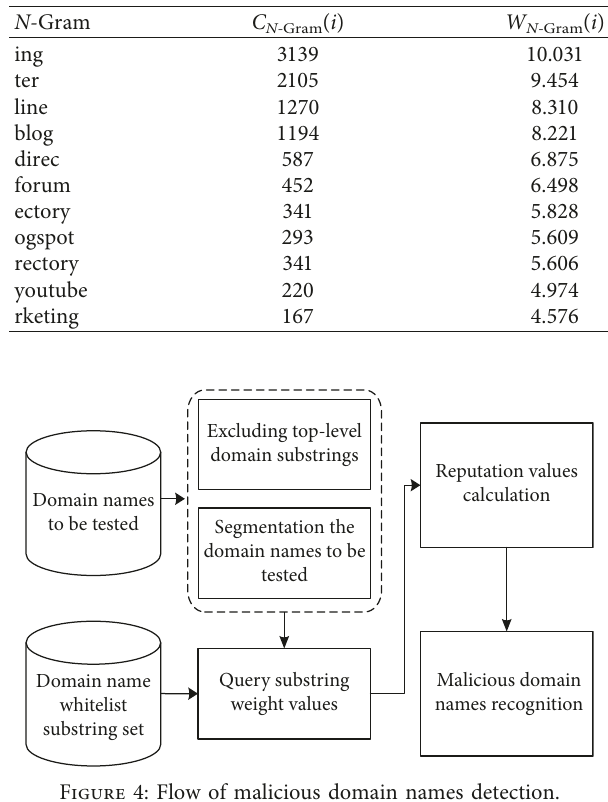
Table 3: Partial domain names substring weight values from the top 100,000 domain names in Alexa 2013.